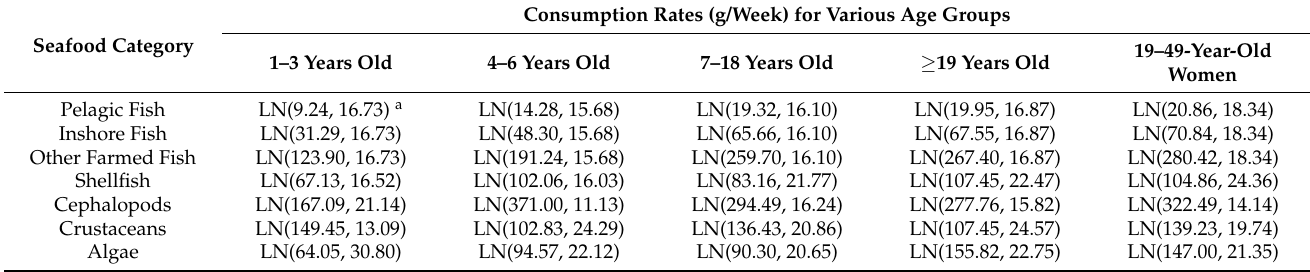
Table 2. Consumption rates for the seven seafood categories among different exposure populations. Consumption Rates (g/Week) for Various Age Seafood Category